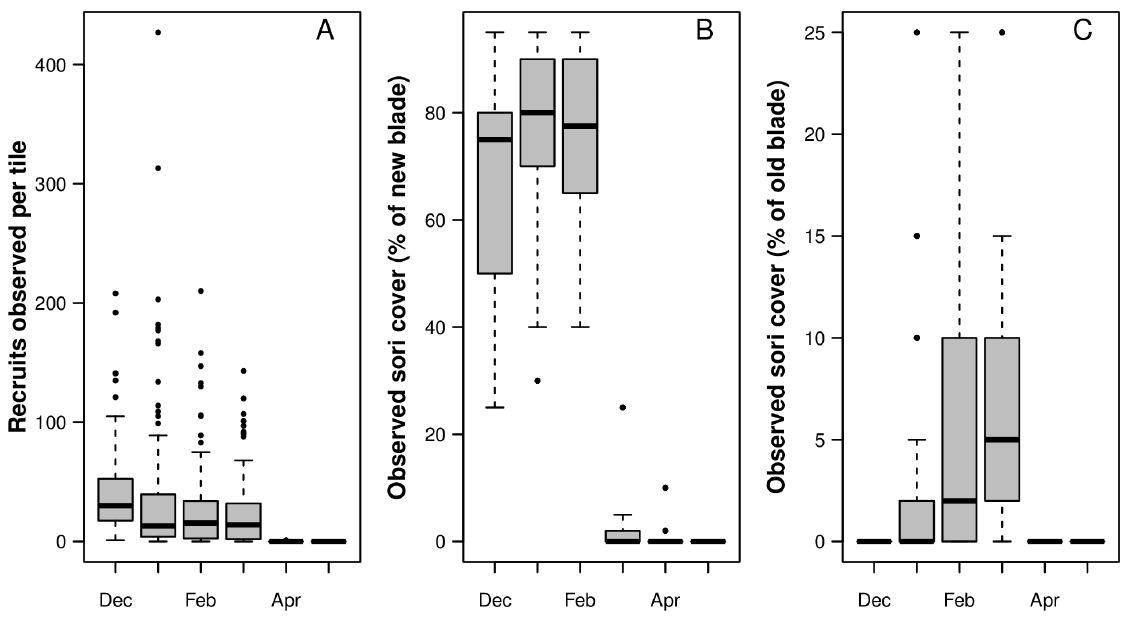
Figure 1. Summary of results from the field experiment (December 2007–May 2008). Boxplot A shows the number of recruits observed on the tiles. Boxplot B shows sori coverage observed on the new parts of each blade, while C shows sori coverage observed on the older parts of each